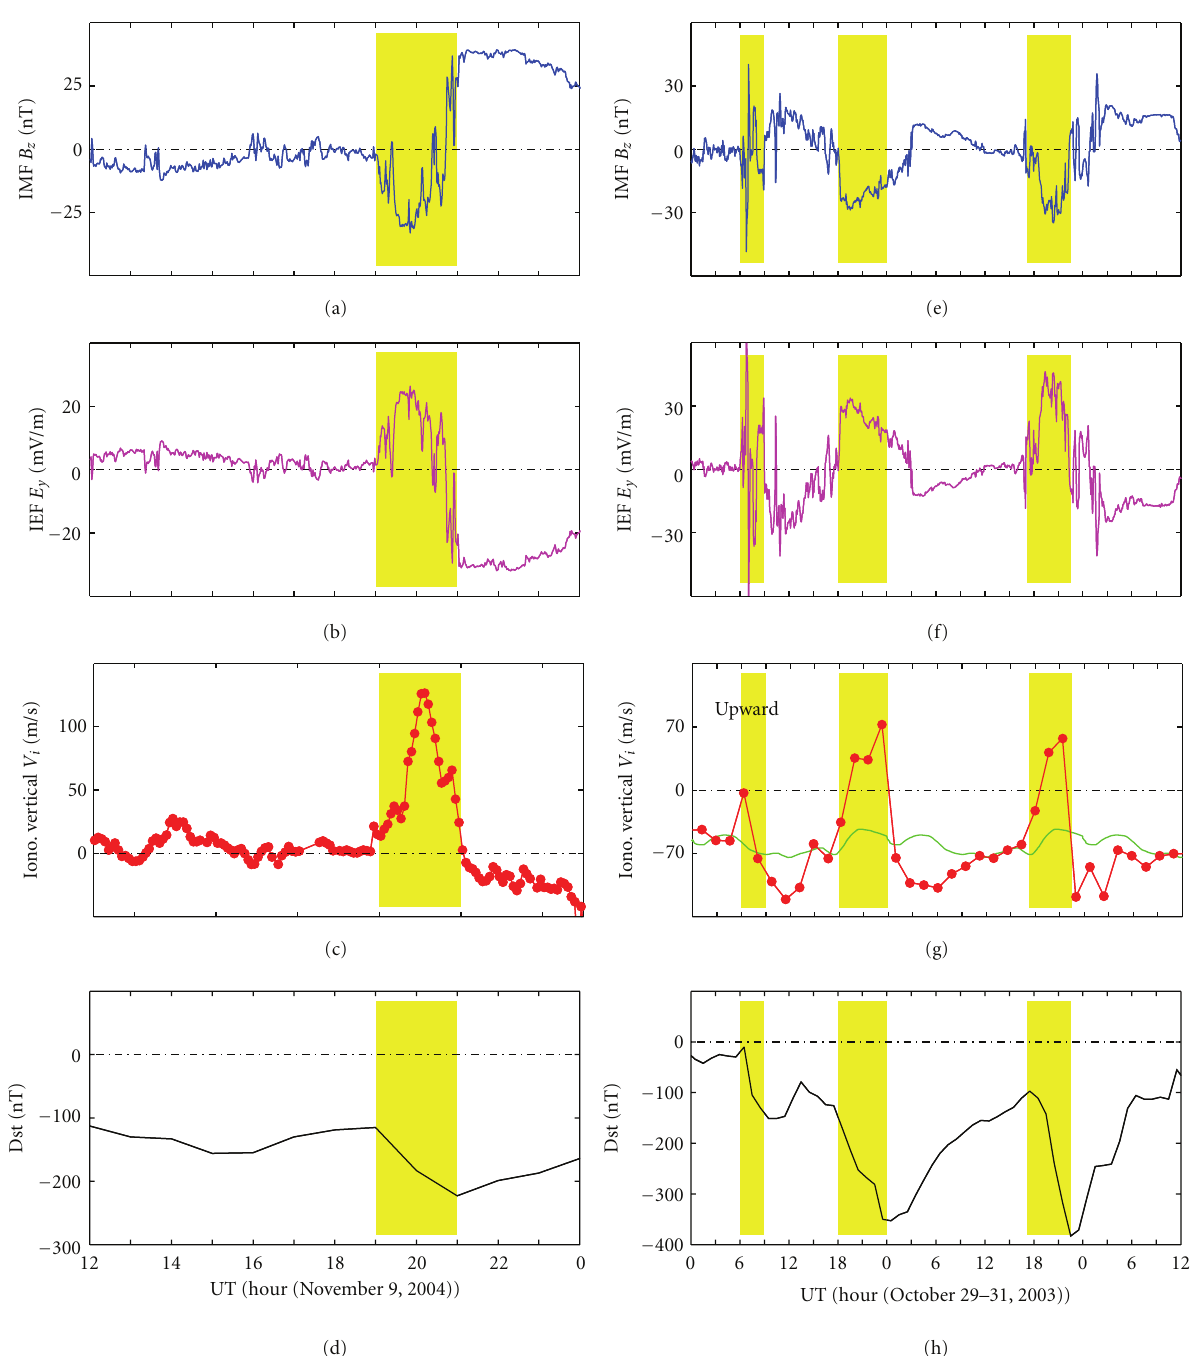
Figure 1: Examples of penetration electric fields during magnetic storms. Figures 1(a)–1(d) show interplanetary magnetic field (IMF) south- north ( B z ) component, interplanetary electric field (IEF) dawn-dusk ( E y ) component, (c) ion vertical velocity in the equatorial ionosphere measured by the Jicamarca incoherent scatter radar, and (d) Dst index on 9 November 2004, respectively. Figures 1(e)–1(h) show the case during 29–31 October 2003; the ion vertical velocity in Figure 1(g) was measured by the DMSP F13 satellite. The shaded regions denote the periods of southward IMF and enhanced vertical ion